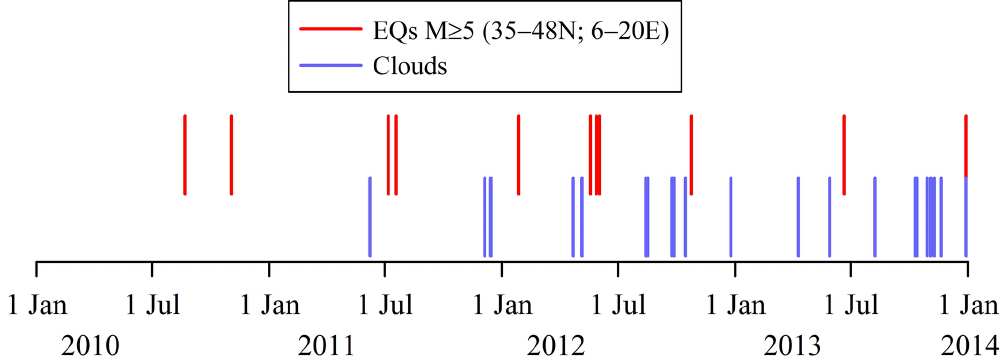
Figure 3. Time series of instances of linear-cloud formations and earthquake occurrences in and near Italy (lat. 35–48 ◦ N, long. 6–20 ◦ E) during